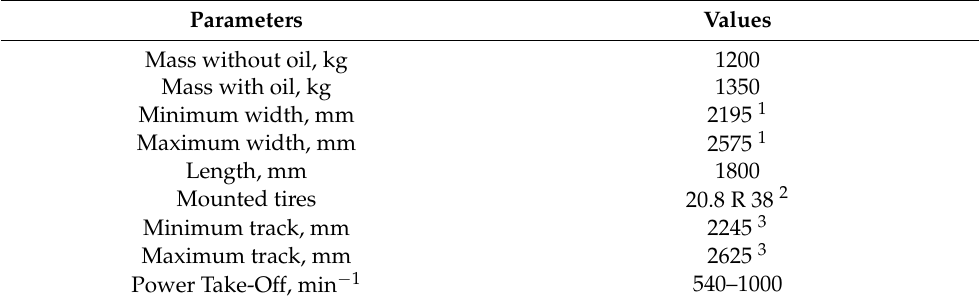
Table 1. Main characteristics of the rear axle-gear box